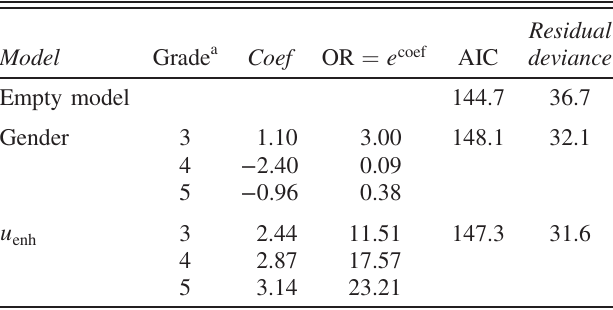
TABLE VI. Results of multinomial logistic regressions for models with substantial support, when the outcome was grade of Math1 ( N ¼ 16 , compared to Grade ¼ 1